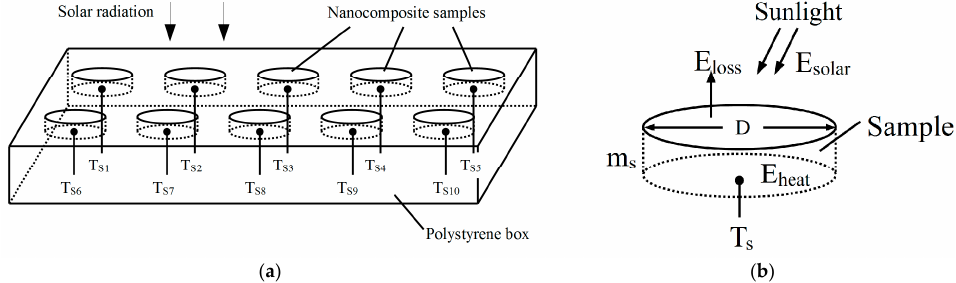
Figure 1. ( a ) Experiment setup for solar energy conversion system testing; ( b ) Heat transfer of a nanocomposites sample.